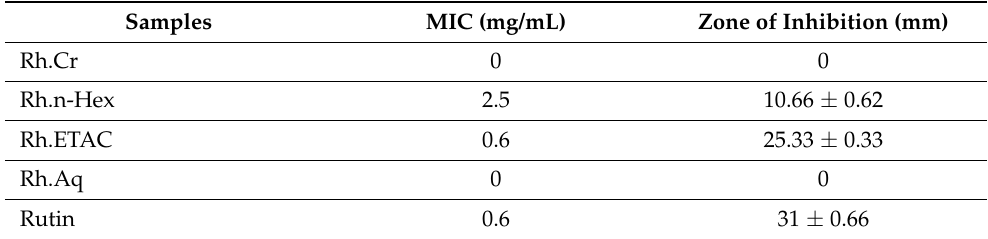
Table 6. Effect of Rumex hastatus crude extract (Rh.Cr) and fractions: n-hexane (Rh.n-Hex), ethyl acetate (Rh.ETAC), aqueous (Rh.Aq) and rutin against H. pylori isolates. Samples MIC (mg/mL) Zone of Inhibition (mm) Rh.Cr